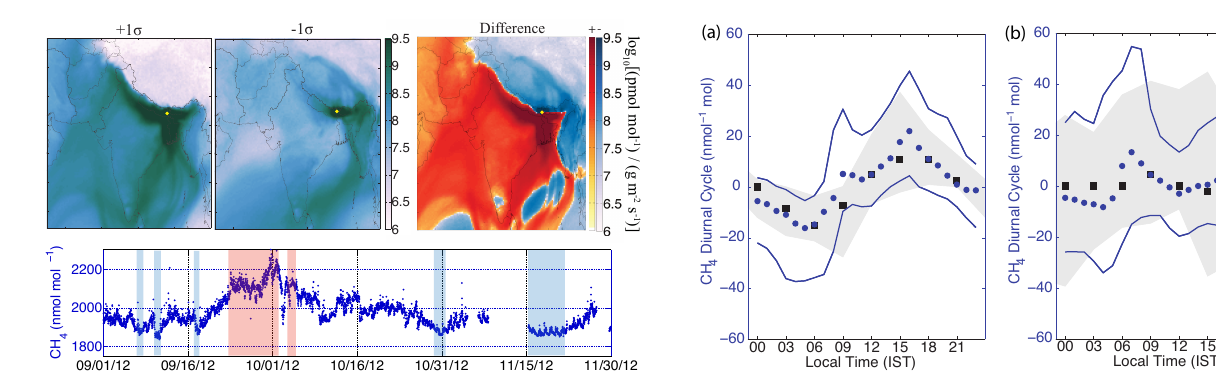
Fig. 8. Same as Fig. 6 but for September 2012 through November 2012.